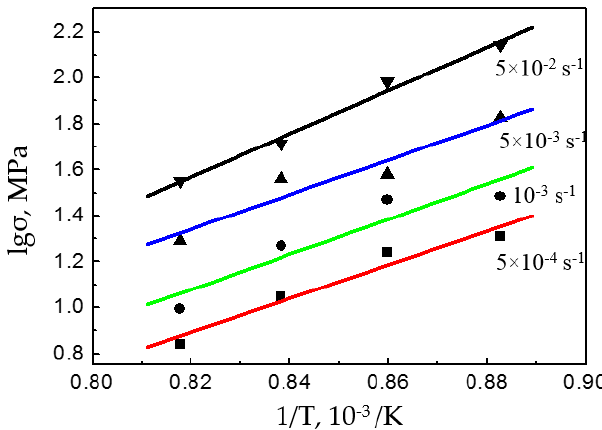
Figure 6. lg σ -1 / T curve of the Ti–6Al–4V alloy. Figure 6. lgσ-1/T curve of the Ti–6Al–4V alloy.